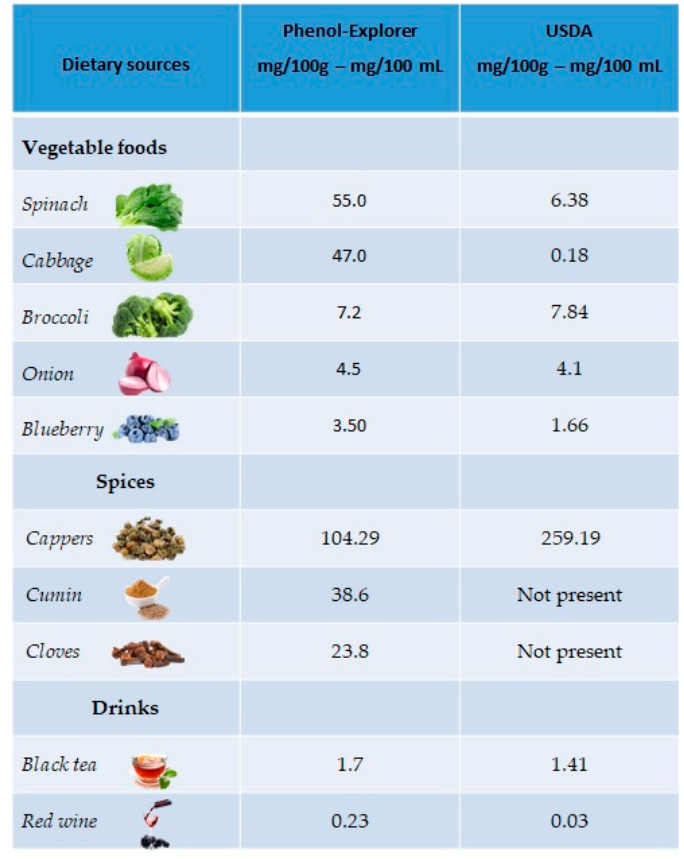
Figure 3. Main foods and beverages that contain kaempferol, according to the database Phenol ‐ Explore (http://phenol ‐ explorer.eu/) and USDA Database for the flavonoid content of selected foods (https://www.ars.usda.gov/).